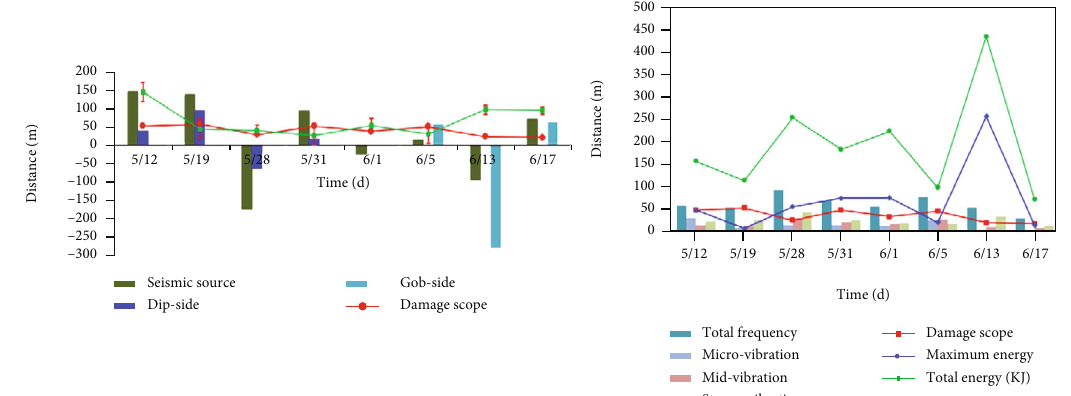
Figure 13: Rock burst event